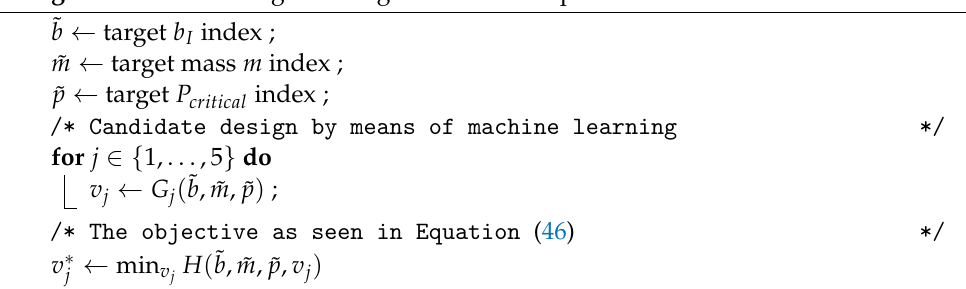
Algorithm 3: Obtaining the design as an inverse